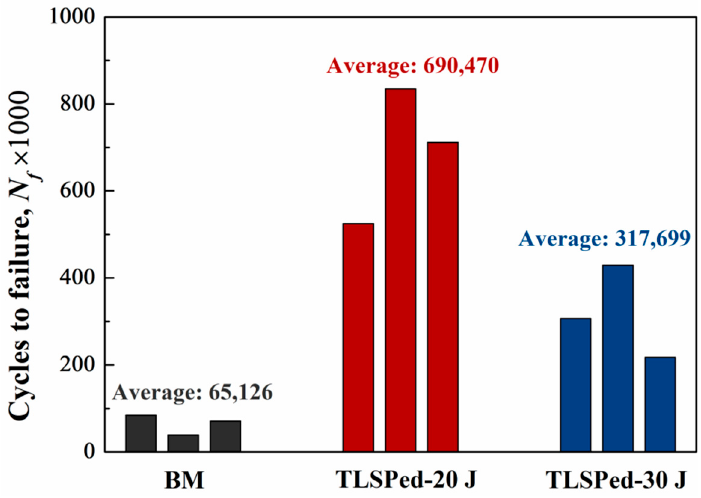
Figure 10. Three-point bending fatigue properties of BM, TLSPed-20 J and TLSPed-30 J specimens.